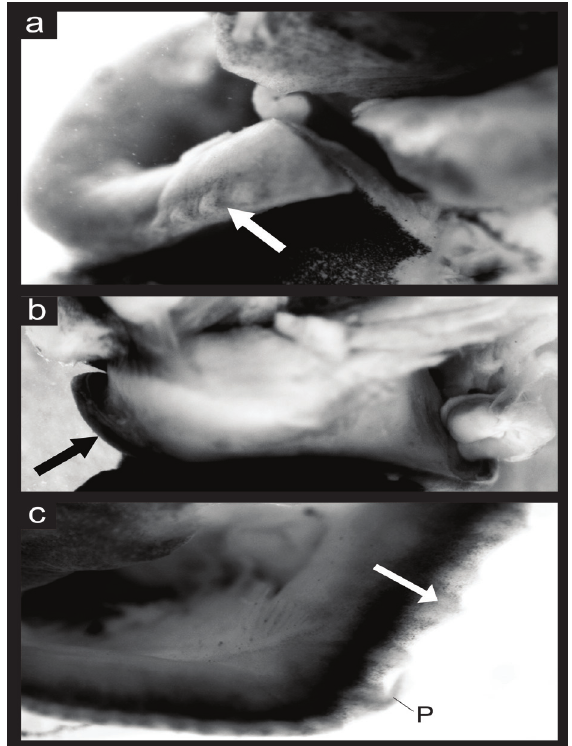
Figure 5 - Mantle border of Sinotaia cf quadrata . a. Folds (white arrow) in a lateral view; b. Black collar observed in the border of the mantle; c. Folds (white arrow) and papillae (P) seen in a plain